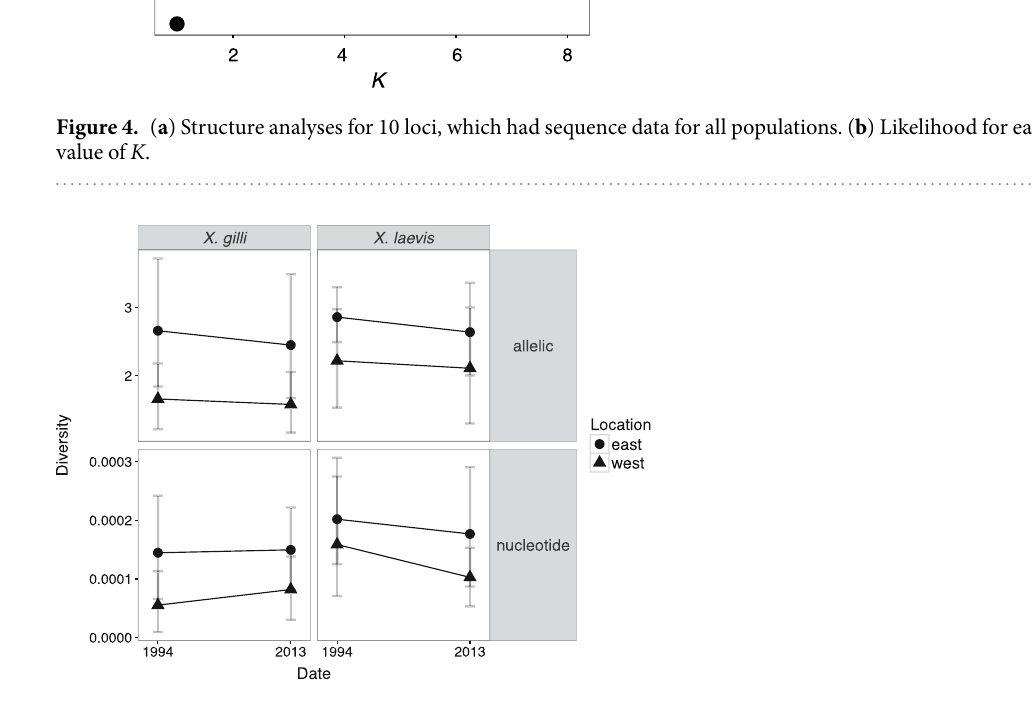
Figure 5. Genetic diversity statistics including rarefied estimates of allelic diversity (top panels) and nucleotide diversity ( π ) weighted by length of sequence; bottom panels). For allelic diversity, the analysis considered the same 10 loci as were analyzed by the STRUCTURE analysis (see Materials and Methods). Allelic diversity for X . laevis did not include PRMT6 locus because this locus only had four alleles for the west 1994